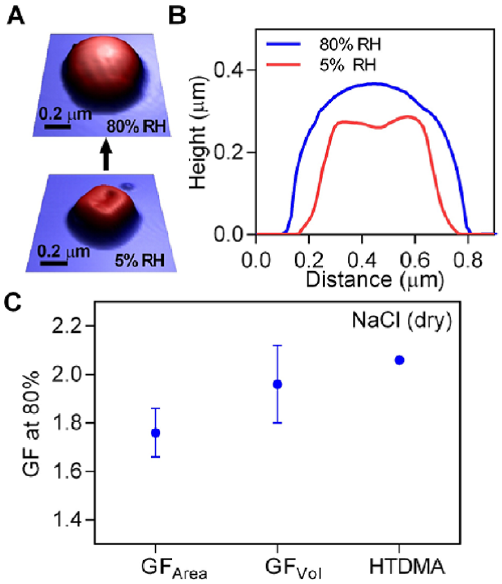
Figure 10. AFM measurements of hygroscopicity of NaCl particles. (a) 3-D AFM images of a NaCl particle at 5% RH and 80% RH; (b) cross section of the particles at 5% (red) and 80% (blue) RH; (c) comparison of hygroscopic growth factors derived from changes in mobility diameter (measured using H-TDMA), area-equivalent diameter (measured using AFM) and volume-equivalent diame- ter (measured using AFM). Reprint with permission by Morris et al. (2016). Copyright 2016 American Chemical